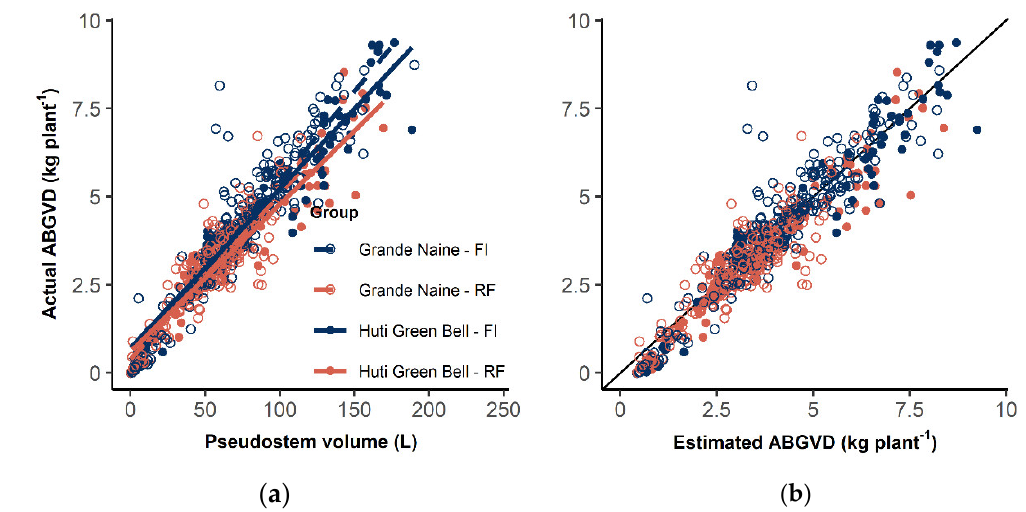
Figure 3. Aboveground vegetative dry matter (ABGVD, kg plant −1 ) models. ( a ) actual ABGVD vs. pseudostem volume (V pseudo ) at sampling (L) for Huti Green Bell (HG) and Grande Naine (GN). Regression models were specific models for treatment and cultivar as shown in Table 5; ( b ) Comparison of actual ABGVD (kg plant -1 ) with estimated ABGVD (kg plant -1 ) as obtained using the specific regression models for treatment and cultivar as shown in Table 5. FI notes full irrigation, RF notes rainfed.